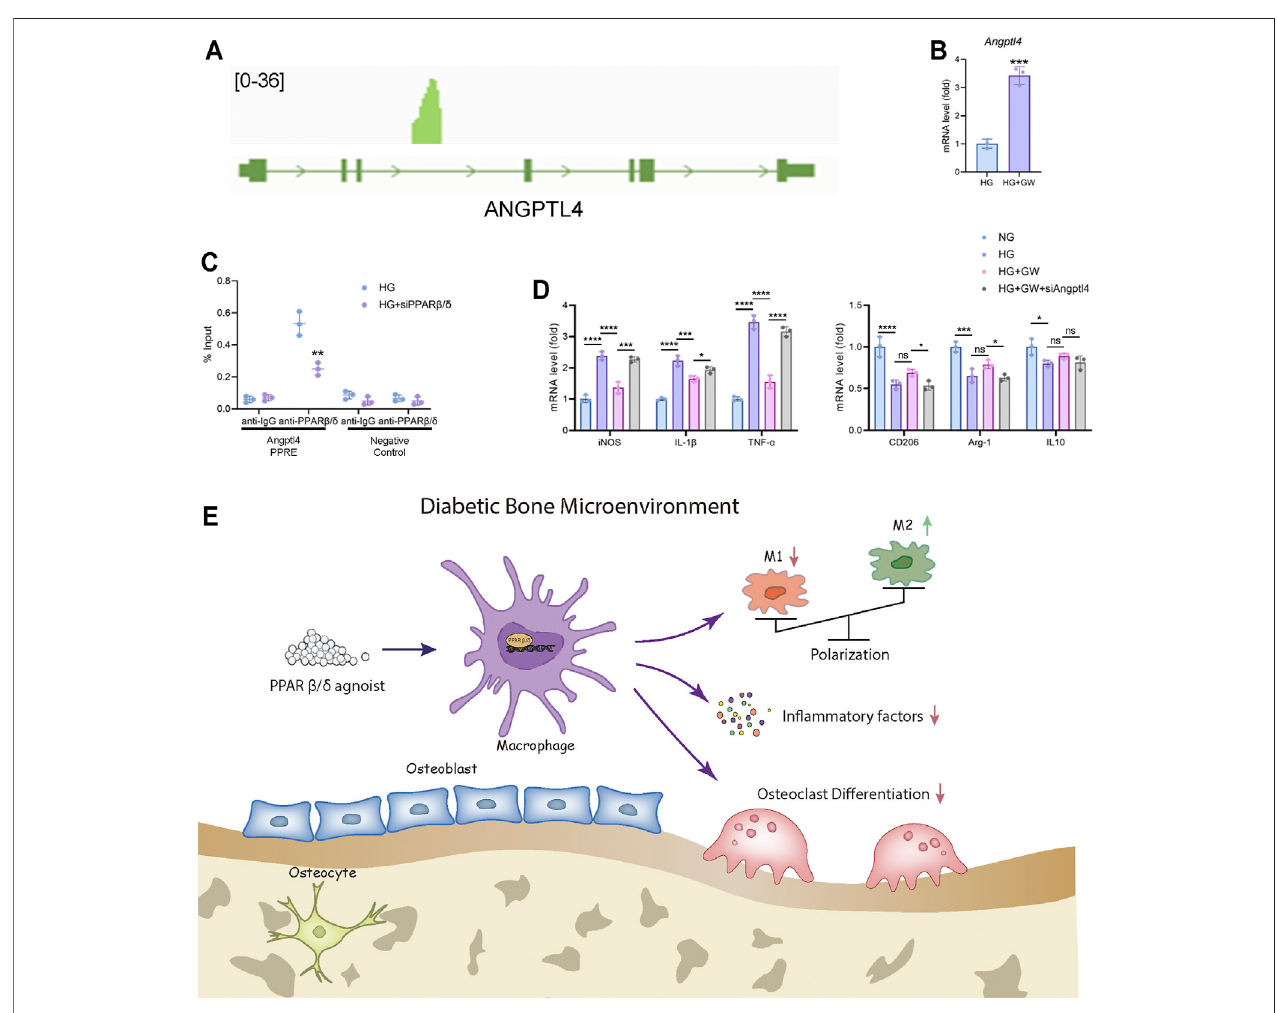
FIGURE 6 | Angptl4 is a downstream target of PPAR β / δ agonist to exert an anti-in fl ammatory effect in macrophage. (A) ChIP-seq analysis of the binding peak of PPAR β / δ in Angptl4 genesegment. (B) RT-PCRresultoftheexpressionlevelof Angptl4 afterPPAR β / δ agonisttreatmentinmacrophage. (C) ChIP-PCRvalidationofthe binding of PPAR β / δ to the PPRE region of Angptl4 . (D) RT-PCR results of PPAR β / δ knockdown on the expression of macrophage polarization-related genes. (E) The mechanism diagram of PPAR β / δ agonist alleviating diabetic osteoporosis. Data were expressed as mean ± SD. The p values were calculated by two-tailed Student ’ s t test or one-way ANOVA. (ns, not statistically signi fi cant, * p < 0.05, ** p < 0.01, *** p < 0.001, **** p < 0.0001).